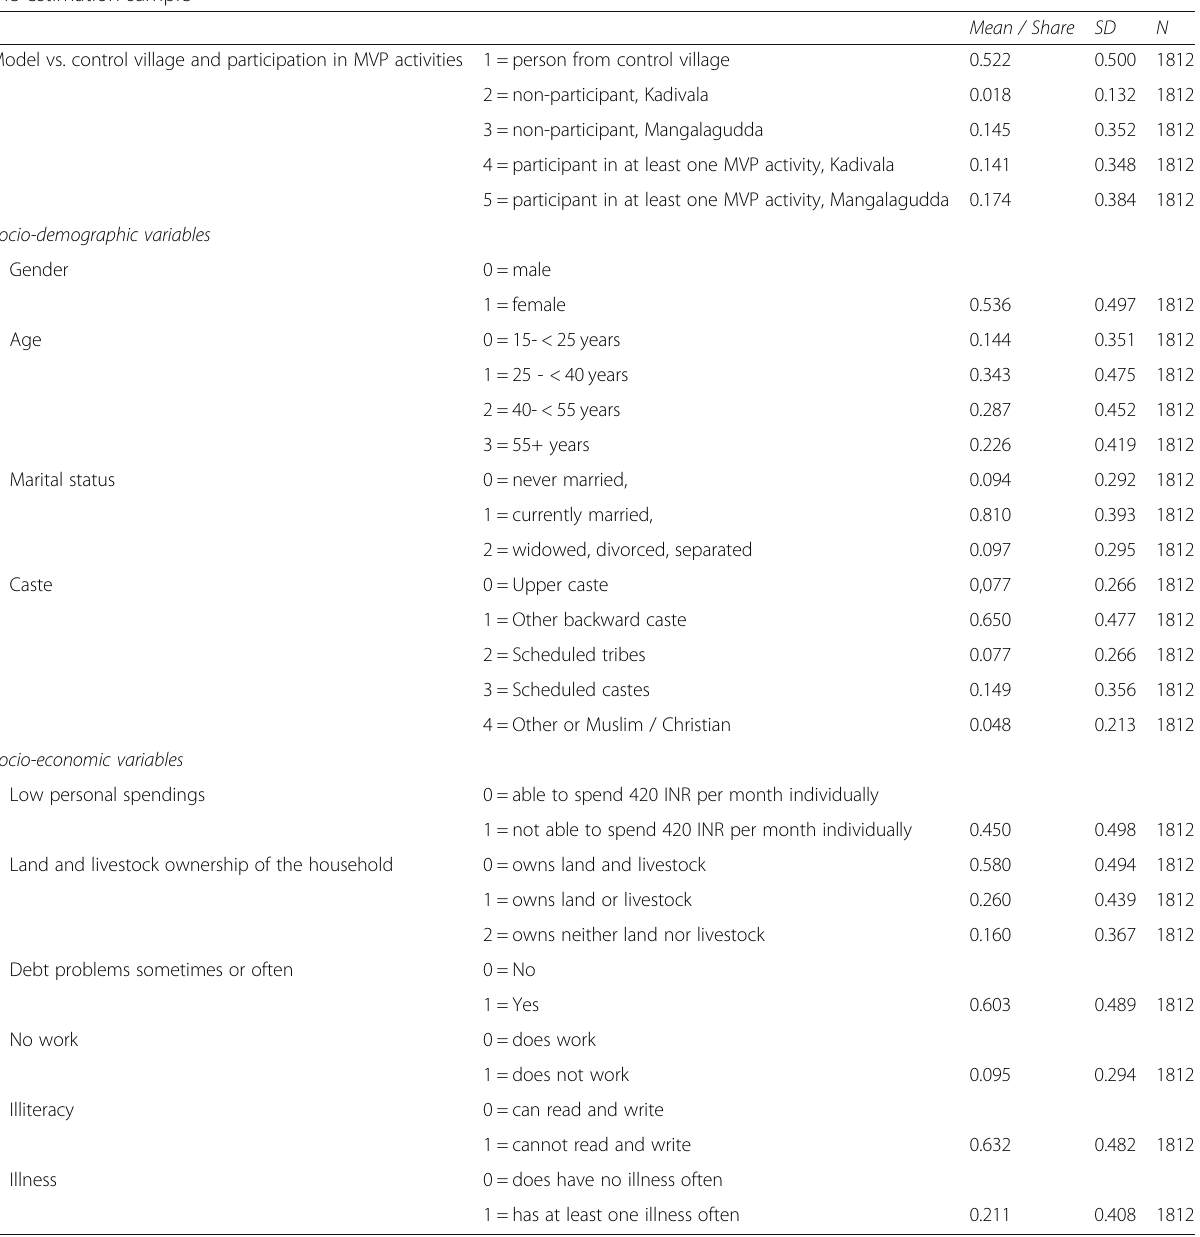
Table 1 Socio-demographic and socio-economic control variables as determinants of personal well-being, descriptive statistics from the estimation